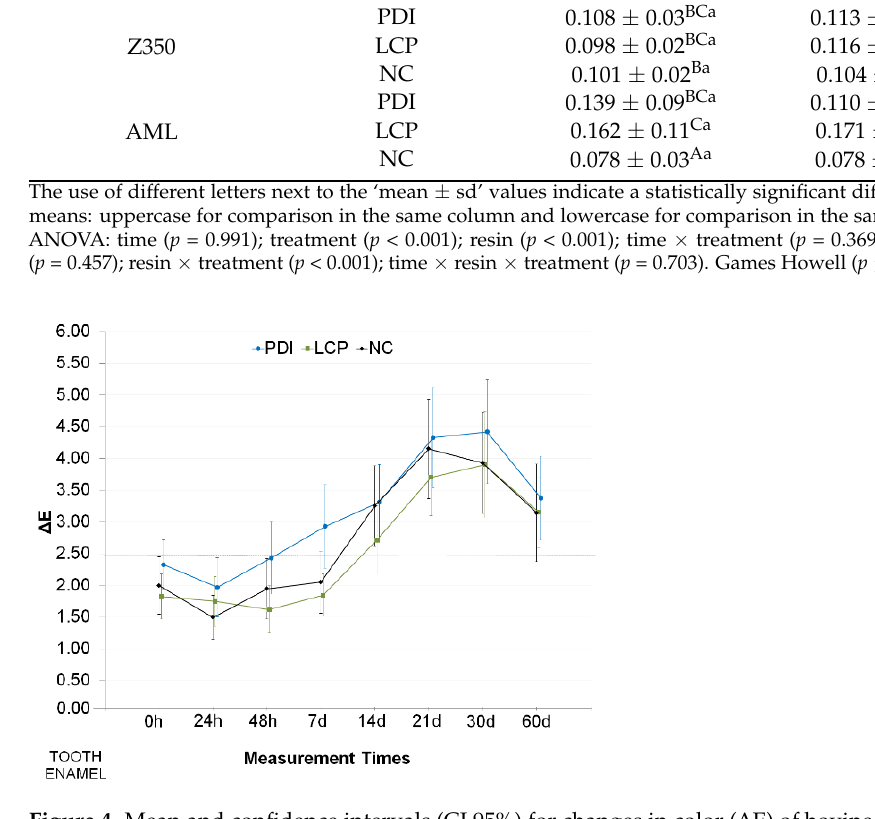
Figure 5. Mean and standard deviation for color changes ( A ), surface microhardness ( B ), and surface roughness (µM) ( C ), obtained on tooth enamel surfaces following treatment (PDI: curcumin-mediated photodynamic inactivation in a liquid crystal precursor system; LCP: only the liquid crystal precursor system without curcumin; NC: negative control with no treatment; only artificial saliva) at the different evaluation times. ‘0 h’ indicates color evaluations performed immediately after treatments; ‘Before’ indicates evaluations performed before treatments, and ‘60 days’ indicates evaluations per- formed after 60 days of treatment (stored in artificial saliva). In the chart labeled ( A ): Mixed ANOVA: time ( p < 0.001); treatment ( p = 0.444); time × treatment ( p = 0.852). In the chart labeled ( B ): Mixed ANOVA: time ( p < 0.001); treatment ( p < 0.001); time × treatment ( p = 0.996). Šidák correction ( p correctio Columns marked with different lowercase letters (a, c, ab,